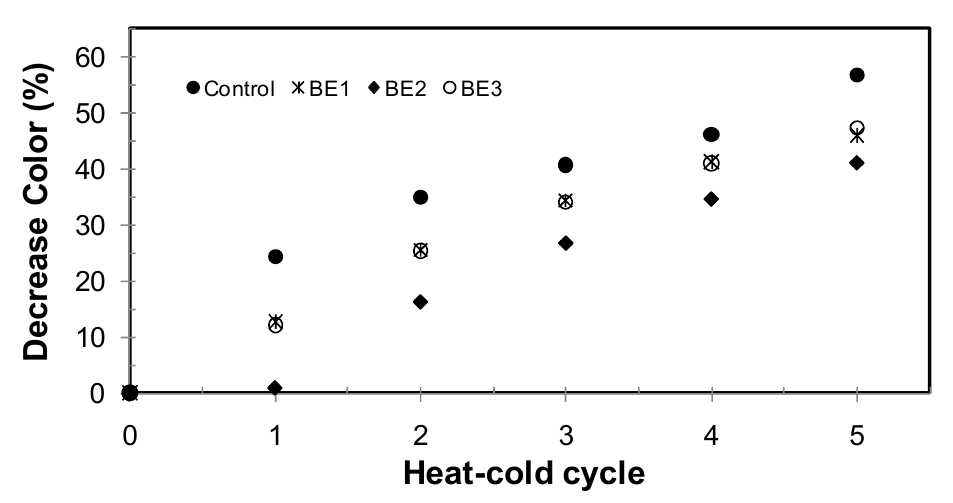
Figure 4. Decrease of color percentage as a function of heat-cold cycles; ● unmodified betalain; * BE 1 ; ♦ BE 2 ; ○ BE 3 .